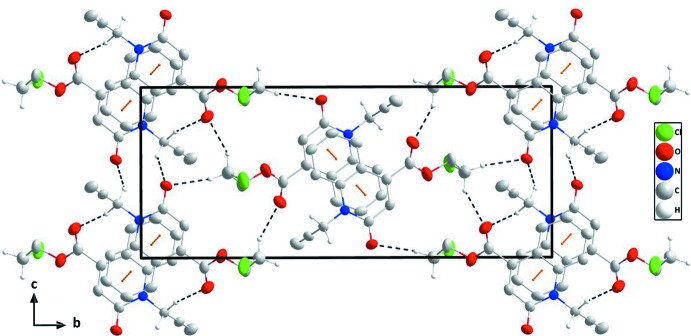
A partial packing diagram viewed along the a-axis direction with the C—HPrpn­yl⋯OCarbx and C—HChlethy⋯OCarbx (Prpnyl = propynyl, Carbx = carboxyl­ate and Chlethy = chloro­eth­yl) hydrogen bonds and π-stacking inter­actions shown, respectively, as black and orange dashed lines.